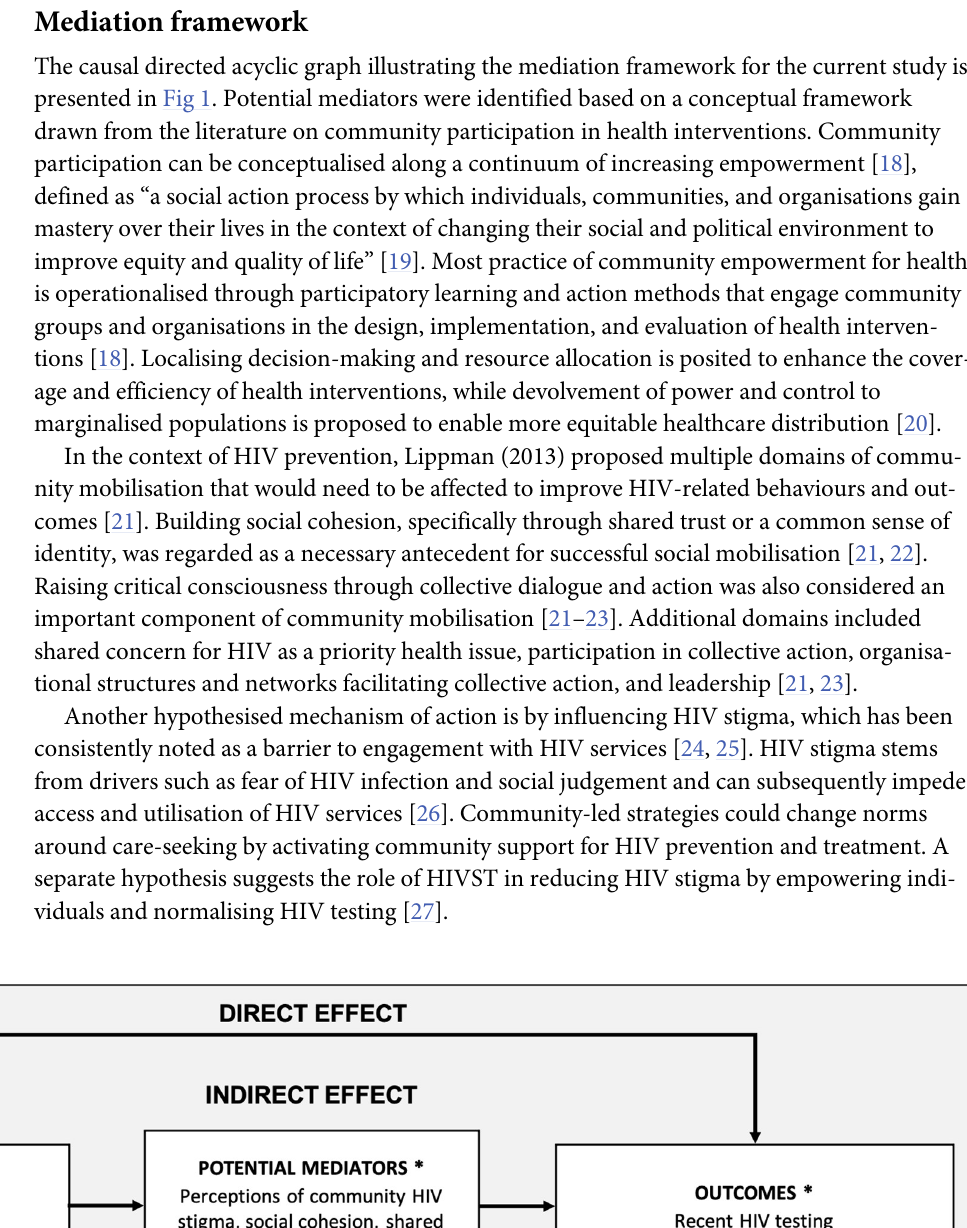
PLOS Global PublicHealth | https://doi.org/10.1371/journal.pgph.0001129 October 27,